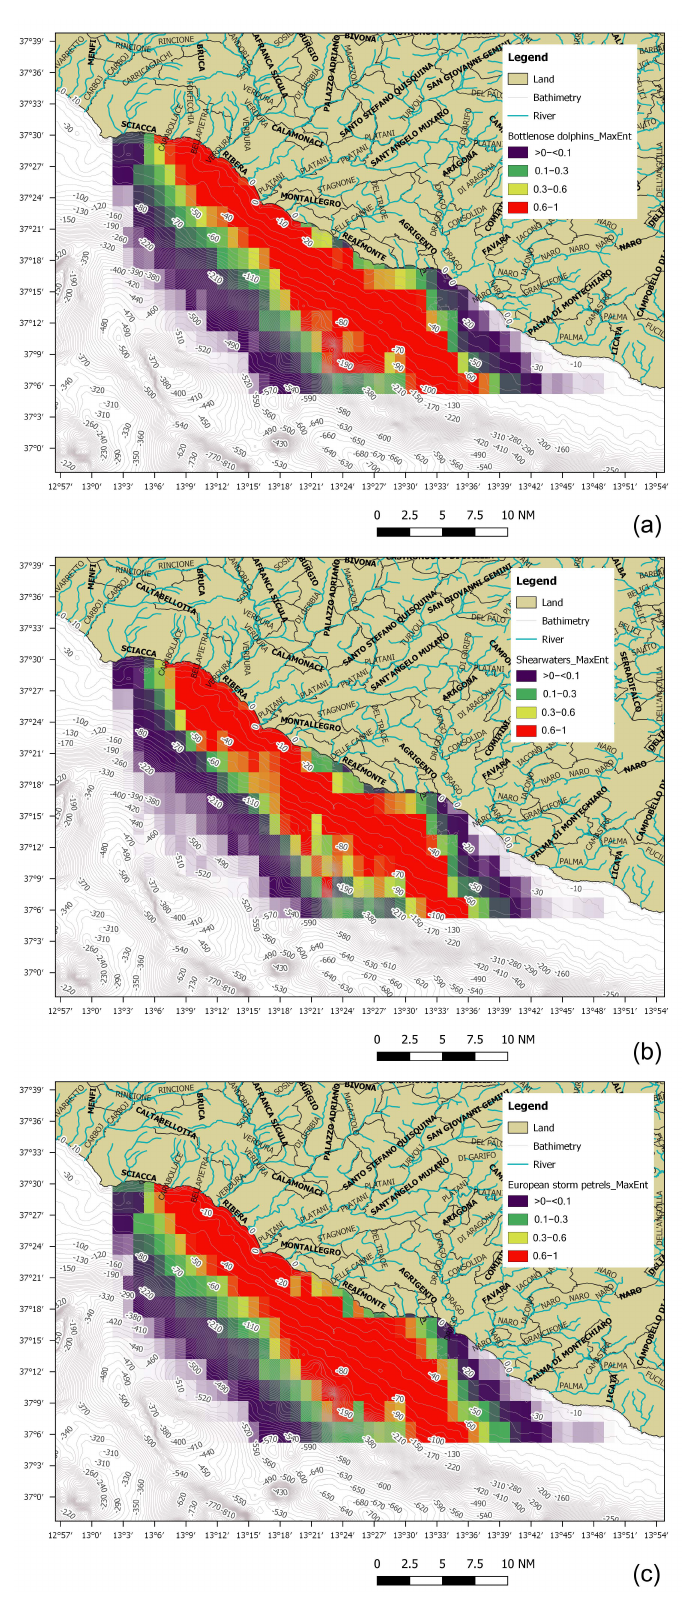
Figure 6. MaxEnt distribution maps of ( a ) bottlenose dolphins, ( b ) shearwaters, and ( c ) European storm petrels in the waters of the Agrigento province, built on the predictive model. The color scale indicates habitat suitability, where the red identifies the hotspot for each species (high habitat